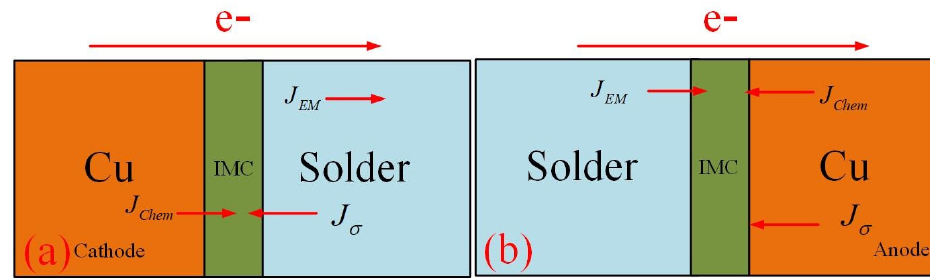
Figure 11. Diffusion models at the cathode and anode.